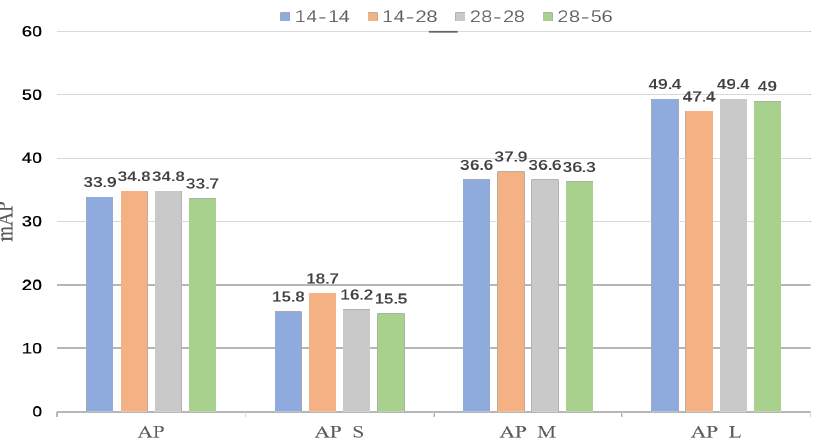
Figure 2. Comparison of the mask evaluation at different resolutions. The first 14 of 14-14 denotes that the input size of FCN is 14 × 14 and the second 14 denotes that its output size is 14 × 14. Different input and output were obtained in the same way. The above experiments used Resnet50 [12] as the backbone network, and were trained and validated on the COCO dataset using a 1 training